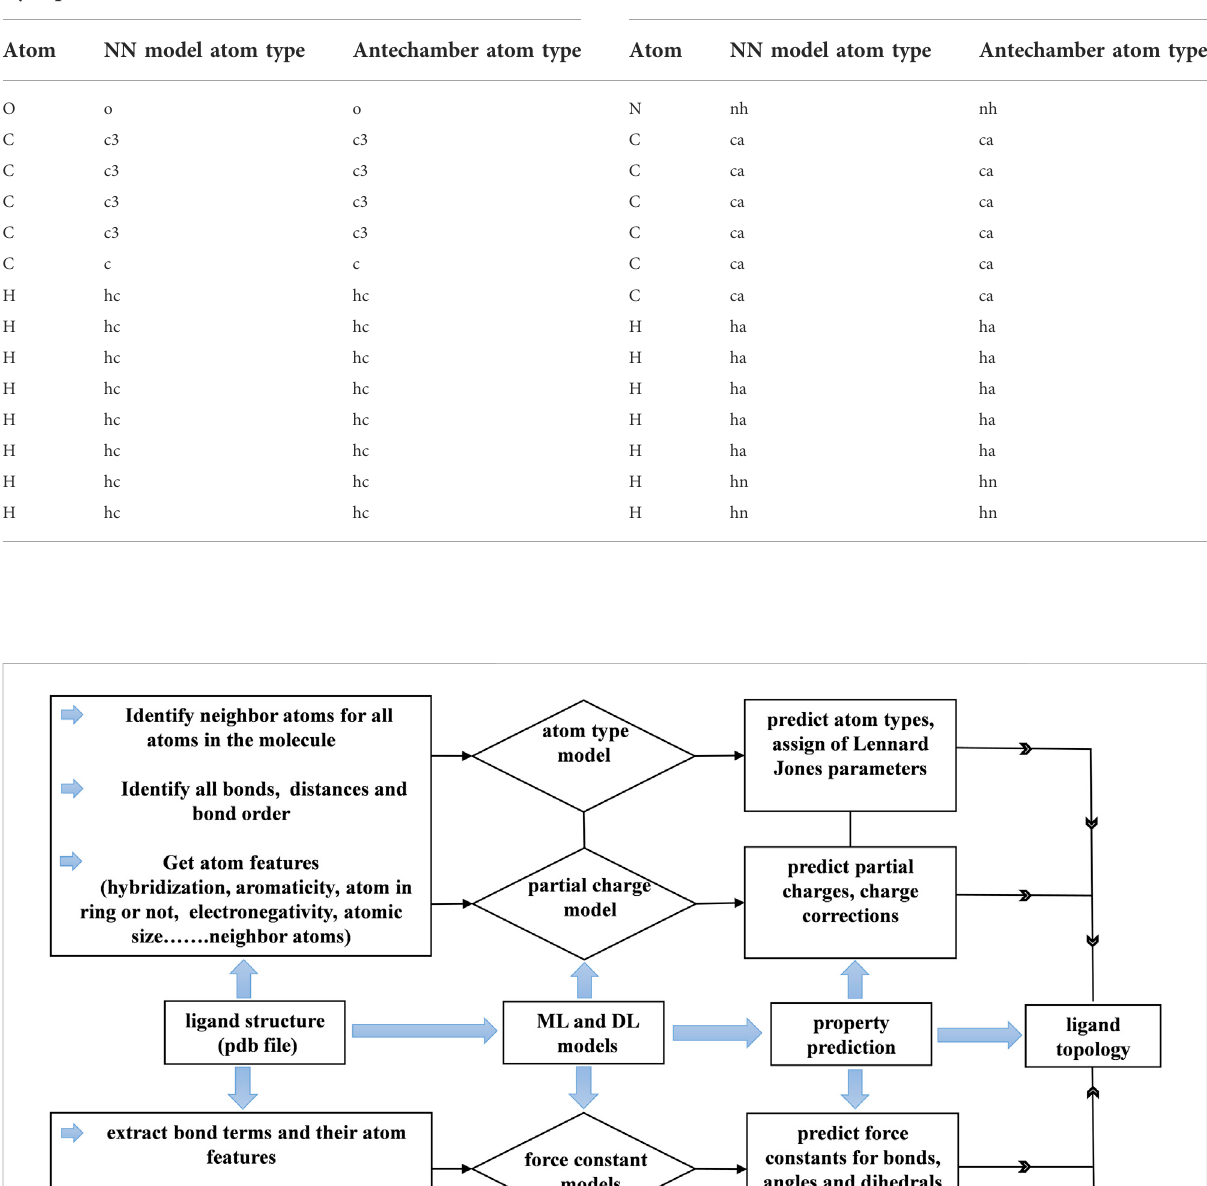
TABLE 3 Comparison of the atom types predicted by the neural network model and antechamber program.